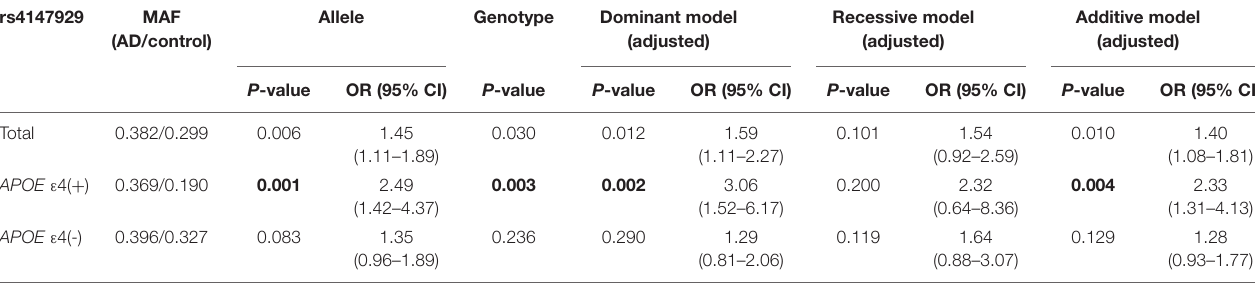
TABLE 2B | Association of rs4147929 of ABCA7 gene with AD risk stratified by APOE ε 4 status. rs4147929